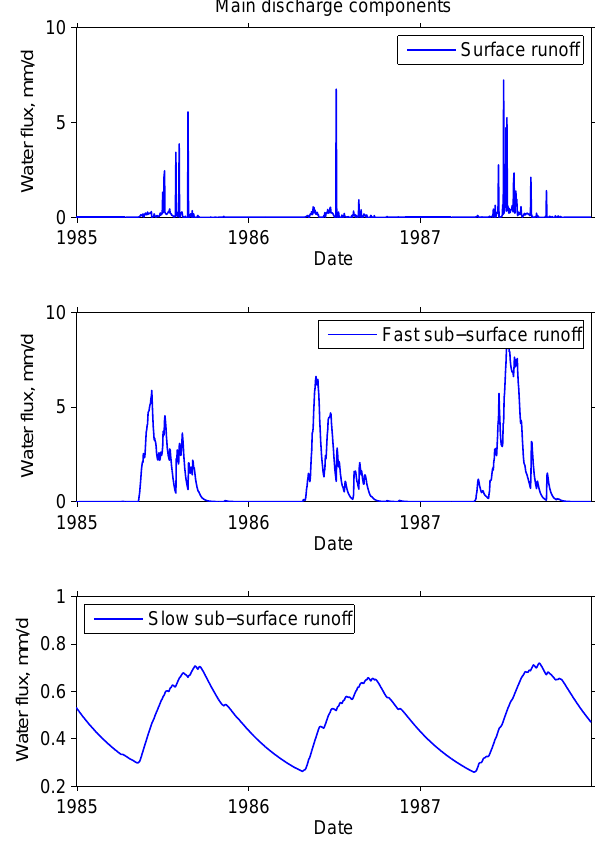
Figure 5. Time series of the streamflow components (direct surface flow, fast subsurface flow and slow (deep) subsurface flow) corre- sponding to the parameter set of Table 3 and the discharge plot of Fig.